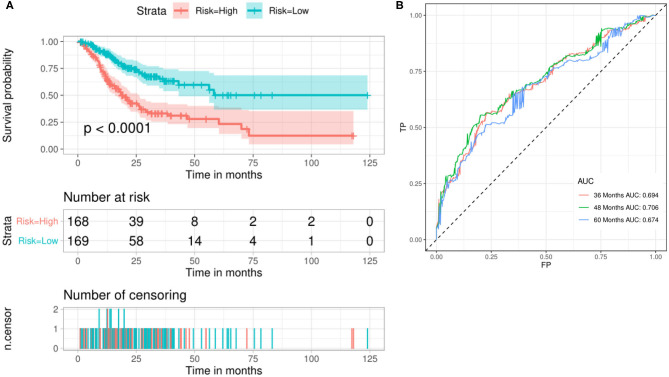
Assessment of the prognostic value of the predictive model in the TCGA GC training cohort. (A) Survival analysis of the predictive model. The upper part shows the Kaplan-Meier curves for the high- and low-risk groups; the middle shows the number of living patient variations with time in the high- and low-risk groups; the bottom shows the number of censoring variations with time in the high- and low-risk groups. Red color represents low-risk group data, whereas blue color represents high-risk group data. (B) ROC curves of predictive models at 3, 4, and 5 years. Red color represents 3 years, green color represents 4 years, and blue color represents 5 years.